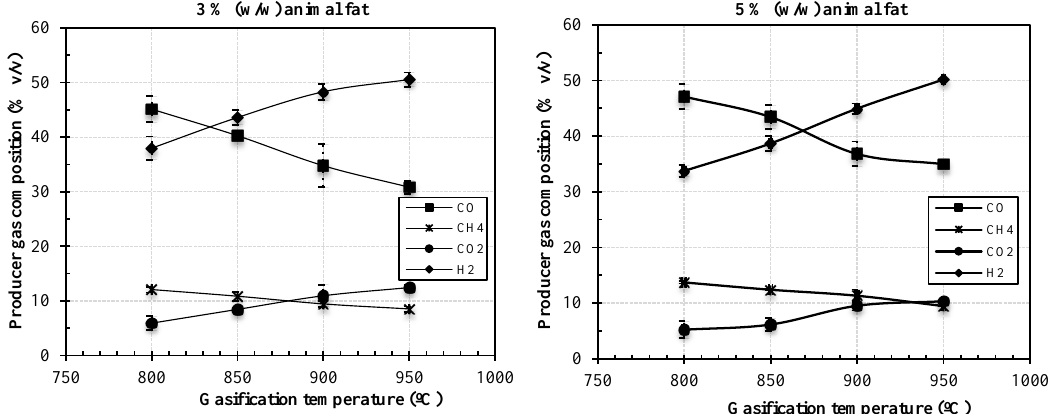
Figure 7. Effect of gasification temperature and fat content in the producer gas composition.